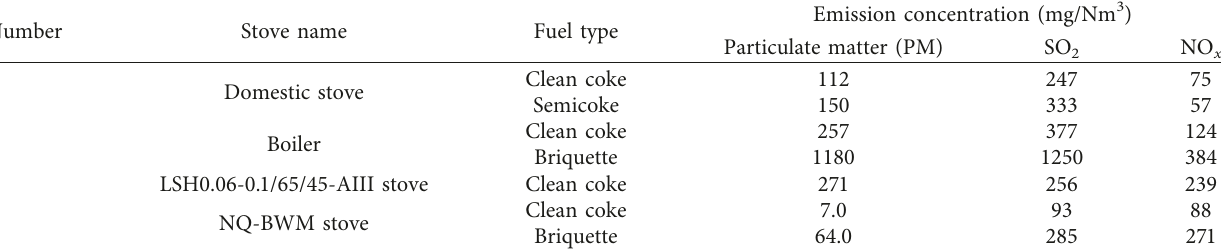
Table 8: The particulate matter, SO 2 , and NO x emissions from burning clean coke in several different stoves. Number